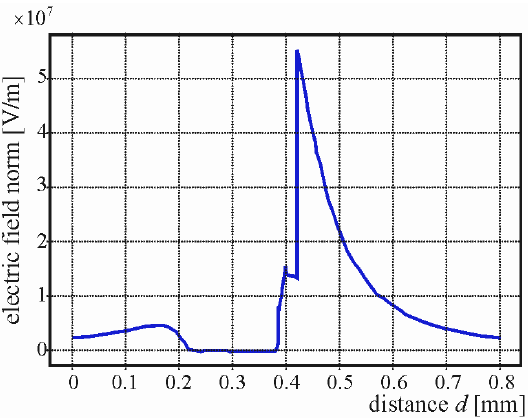
Figure 16. Impact of ionization (triangle zone) on potential distribution ( a ) and electric field ( b ). Energies 2018 , 11 , x FOR PEER REVIEW